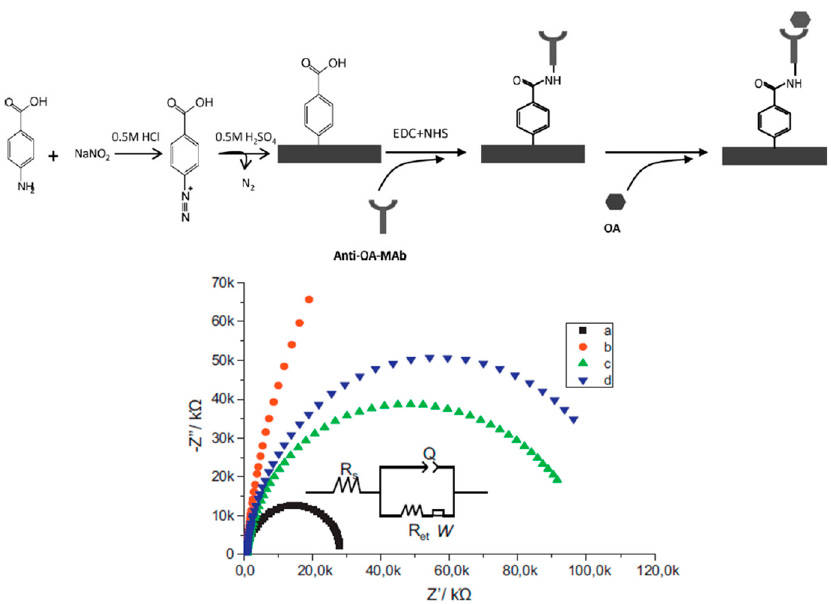
Figure 15. A schematic presentation of the surface chemistry used for immobilization anti-okadaic acid (OA) monoclonal antibody on an SPE electrode, and Nyquist plots of 1 mM [Fe(CN) 6 ] 4 − /3 − for ( a ) bare SPE, ( b ) SPE modified by 4-carboxybenzenediazonium, ( c ) and an antibody, ( d ) in the presence of 10 µg/L ochratoxin. The insert is the equivalent electric circuit applied to fit the impedance spectroscopy. From Reference [98] with permission of Elsevier.